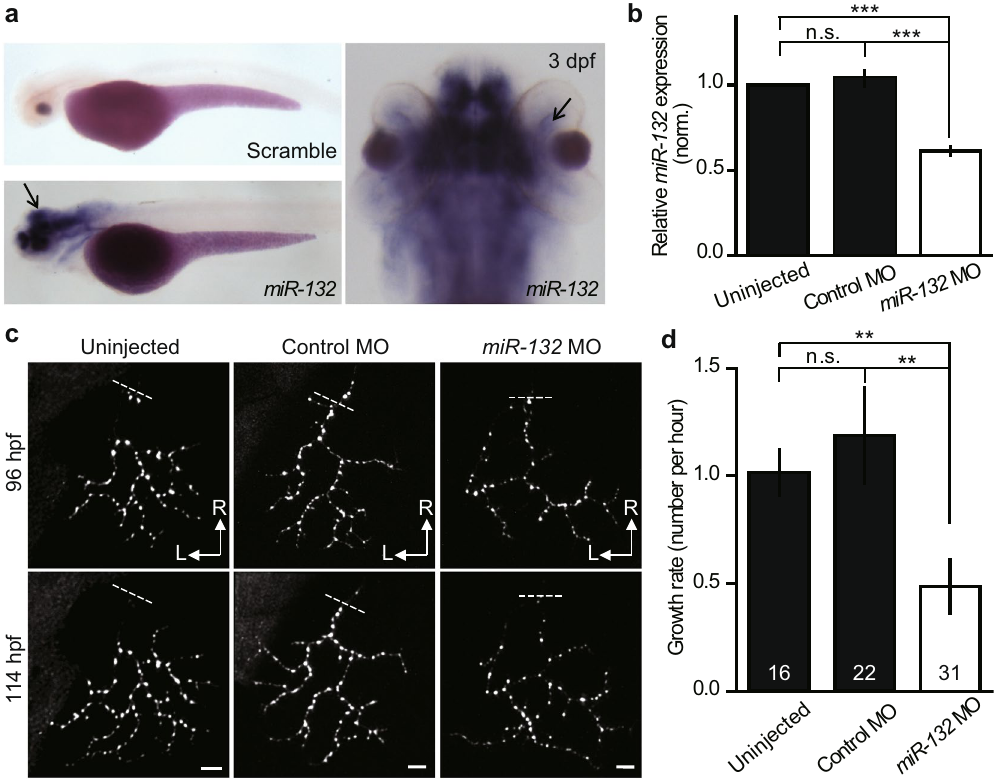
Figure 5. Role of miR-132 in developmental synaptogenesis. ( a ) Lateral (left bottom) and dorsal (right) view of whole-mount in situ hybridization of miR-132 in zebrafish larvae at 3 dpf. The black arrows in left and right panels indicate the signal in the optic tectum and the RGC layer, respectively. Left top, whole-mount in situ hybridization of a scramble probe as a control. ( b ) Knockdown efficiency of miR-132 MO. Quantification of mature miR-132 in 3-dpf zebrafish larvae without MO injection or injected with either control or miR-132 MO by relative quantitative real-time PCR. Data were summarized from six independent experiments. n.s., no significant, *** P < 0.001 (One-way ANOVA and Tukey’s multiple comparison test). ( c ) Example of time series (from 96 hpf to 114 hpf) images showing the growth of Sypb-EGFP puncta on the same RGC axonal arbors in PGUSG larvae without MO injection or injected with either control or miR-132 MO. The dashed line indicates the position of the first branch point in each axonal arbor. R, rostral; L, lateral. Scale bar, 5 μ m. ( d ) Summary of the net growth rate of Sypb-EGFP puncta from 96 hpf to 114 hpf. The numbers on the bars indicate the number of RGCs examined. n.s., no significant, ** P < 0.01 (Two-tailed Unpaired Student’s t